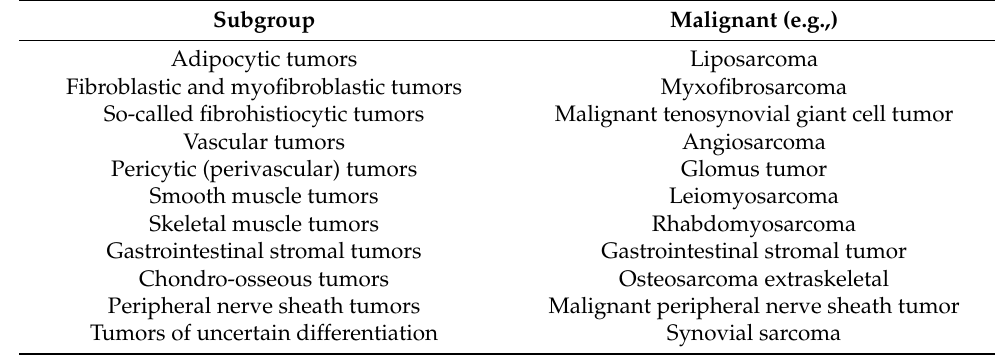
Table 1. Summary of the WHO histological classification of